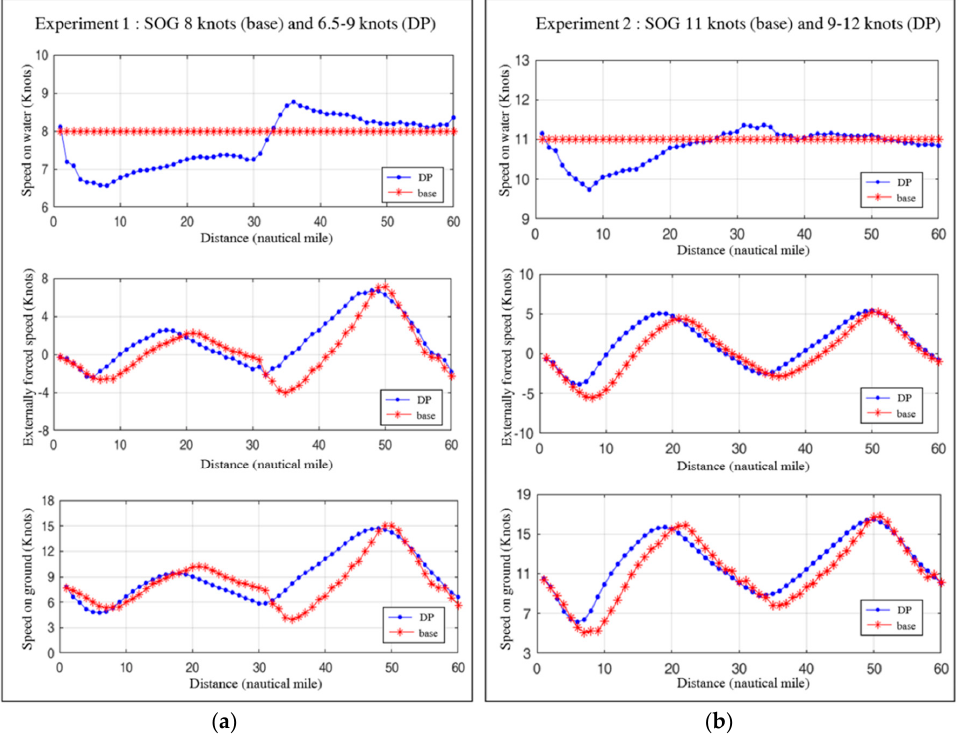
Figure 6. Speeds over water (SOWs), externally forced speed changes, and speed over ground (SOG) for fixed-speed navigation and dynamic programming (DP)-based speed adjustment navigation. ( a ) A towing vessel of 8 kt SOW; ( b ) a cargo vessel of 11 kt SOW.